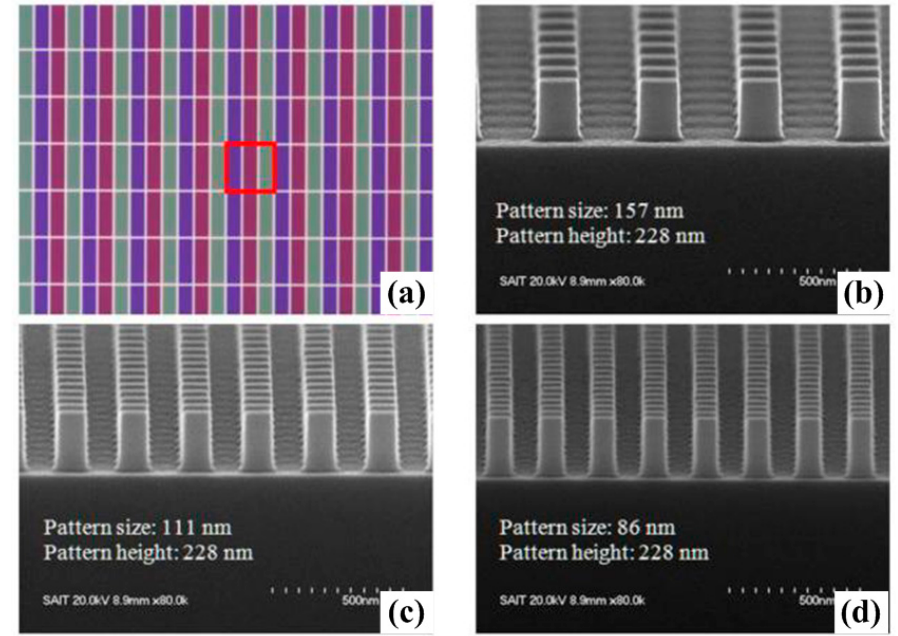
Figure 3. ( a ) Optical microscope image of photonic crystal array. Scanning electron microscopy (SEM) images of the 2D pillar pattern for ( b ) red; ( c ) green; and ( d ) blue color filters. All figures are adapted from reference [82].